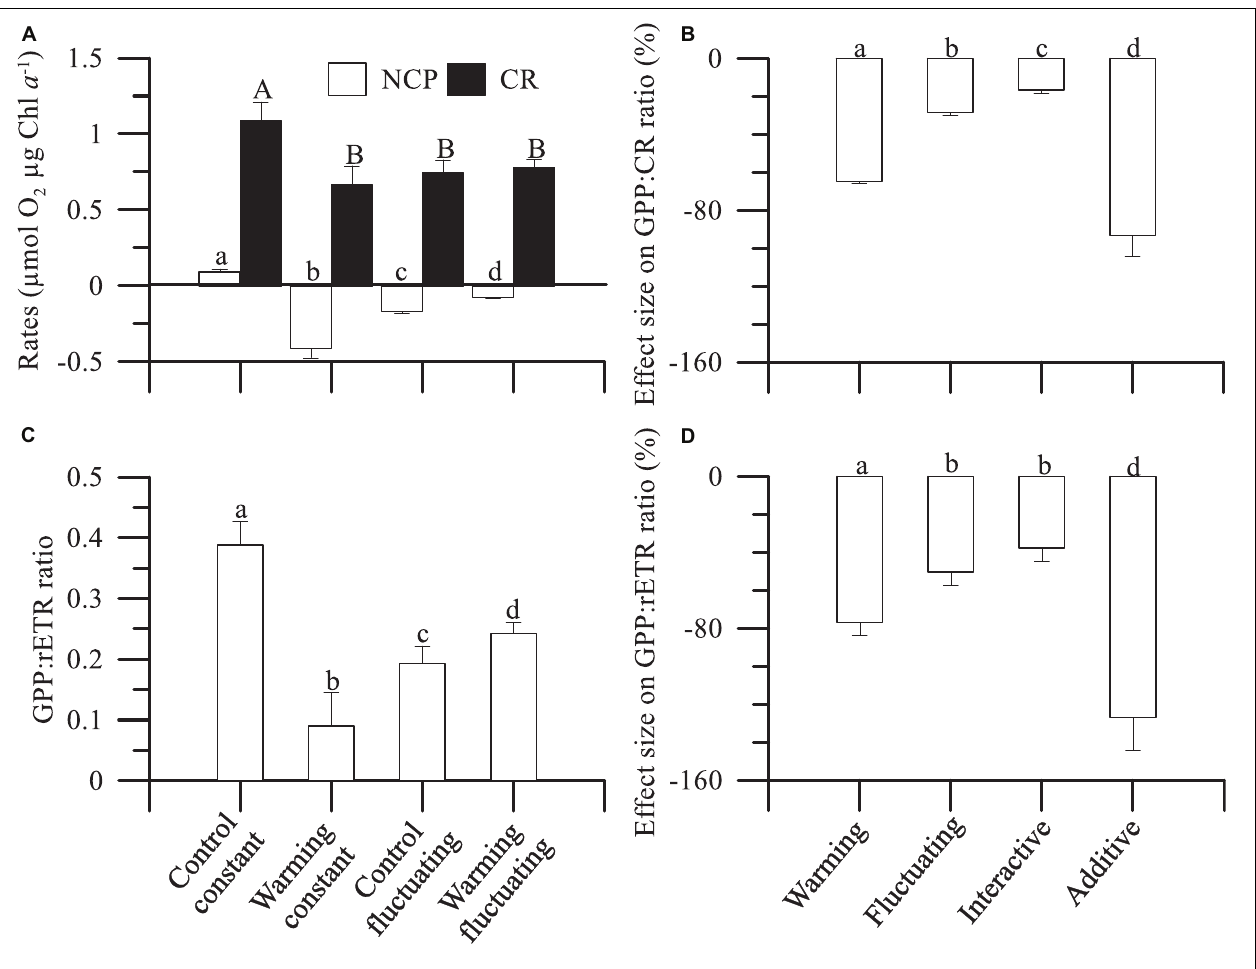
FIGURE 4 | Mean ( ± SD) (A) net community production (NCP) and respiration rates (in mol O 2 µ g Chl a − 1 ) and (C) gross primary production:relative electron transport (GPP:rETR) ratios, integrated over the entire duration of the experiment, in microbial plankton communities exposed to: two temperature treatments [Control (15 ◦ C) and warming (18 ◦ C)] and regimes [Constant and Fluctuating ( ± 3 ◦ C respect to Present and Future)]. (B,D) Individual (Warming constant , and Control fluctuating ), interactive (Warming fluctuating ) and additive effect size on GPP:CR and GPP:rETR ratios. Letters on the top of bars denote significant differences by the Least Significant Differences (LSD) post hoc